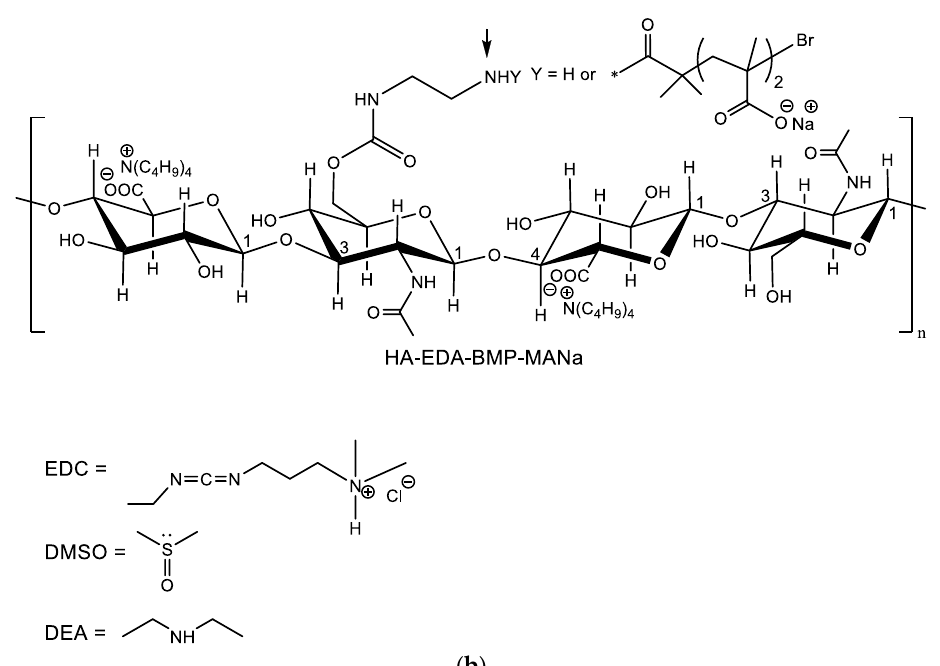
Figure 8 Amphiphilic block-like copolymer membrane surface modifier for the creation of an integrated active-passive fouling release